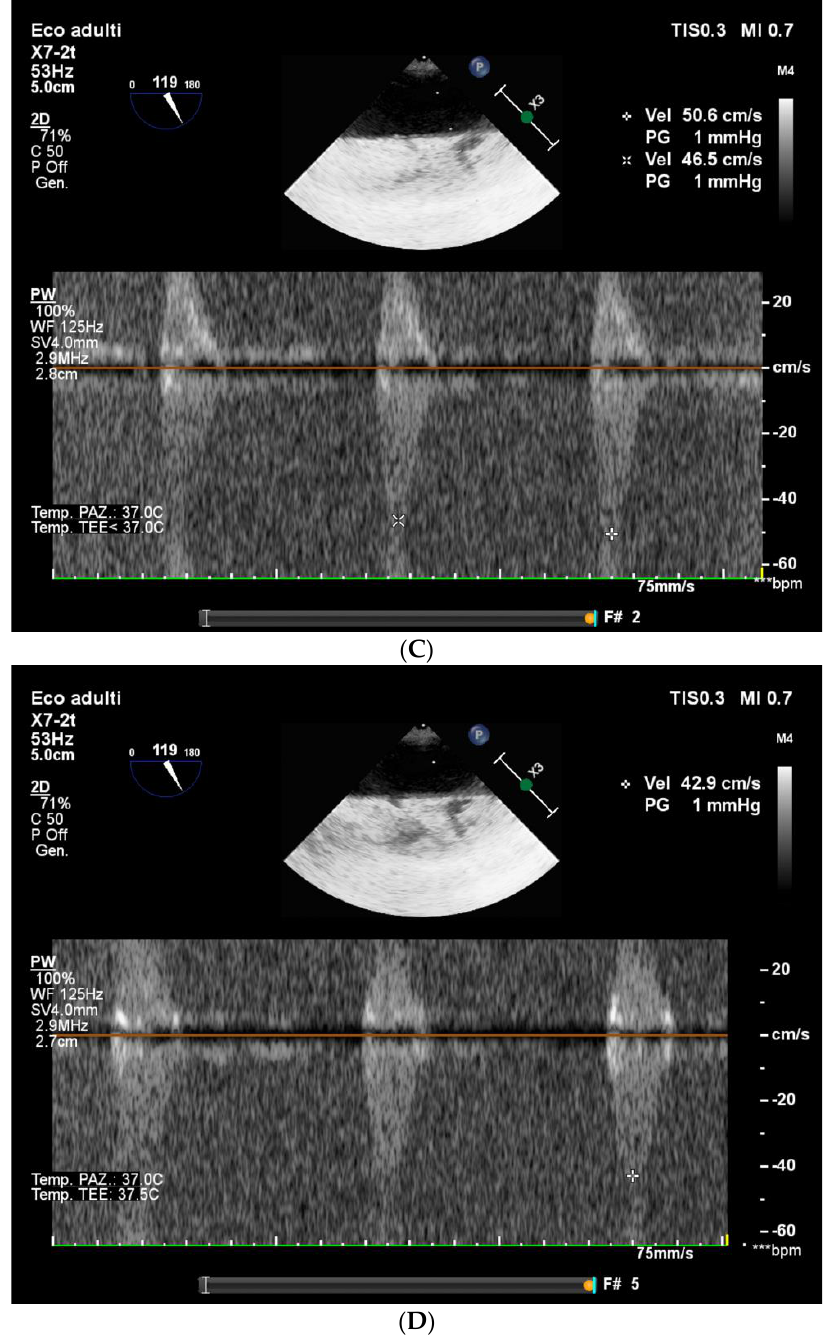
Figure 2. ( A ) Trans-esophageal pulse Doppler evalutaion of the celiac trunk after induction of general anesthesia in patient one. ( B ) Trans-esophageal pulsed wave Doppler evaluation of the celiac trunk at the end of the laparoscopic section of the arcuate ligament in patient one. Notice the variation in the PSV with the mechanical respiratory cycle. ( C ) Trans-esophageal pulse Doppler assessment of the celiac trunk after induction of general anesthesia in patient two. ( D ) Trans-esophageal pulse Doppler evaluation of the celiac trunk at the end of the procedure in patient two.